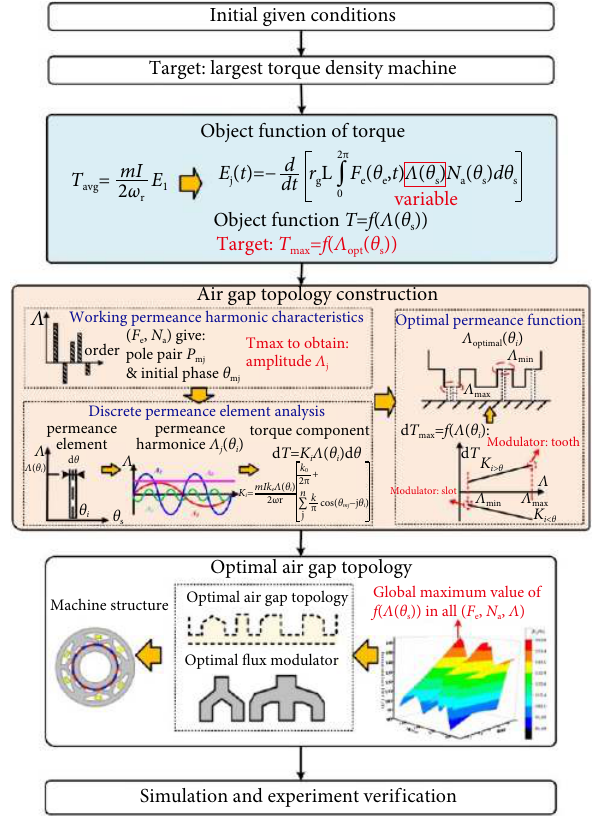
Fig. 26 Flow of quantitative construction method of air gap